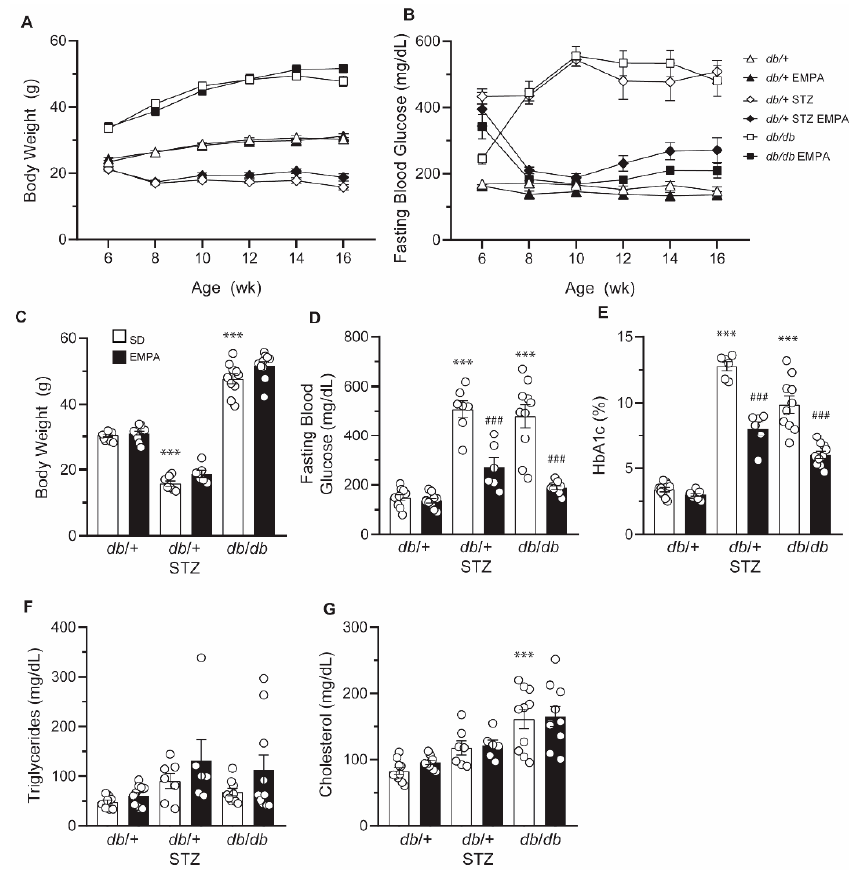
Figure 2. EMPA improves glycemic control in T1D and T2D mouse models. ( A , B ) Biweekly